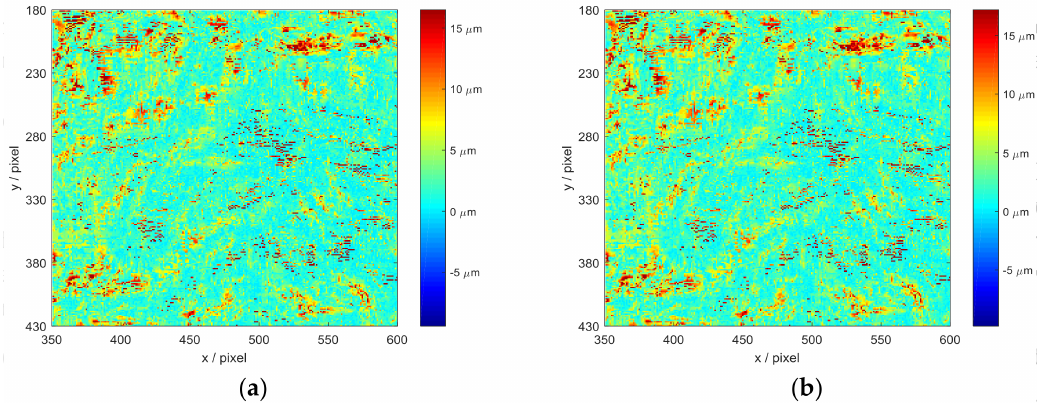
Figure 10. Distribution maps of spatial distance of the ROI in the head, which are measured by IC-GN 2 under two different convergence thresholds: ( a ) Under convergence thresholds of 0.1 and 0.001; and ( b ) Under convergence thresholds of 0.01 and 0.001.